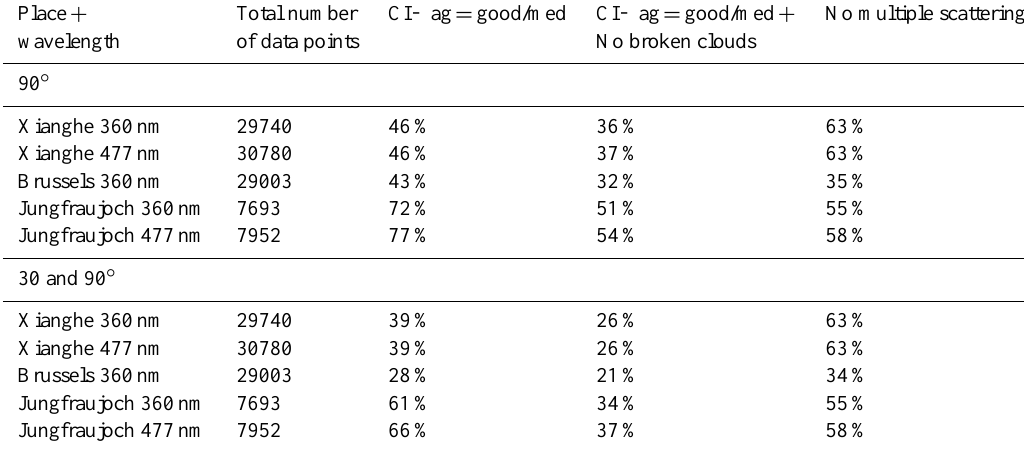
Xianghe 360nm 29740 39% 26% 63% Xianghe 477nm 30780 39% 26% 63% Brussels 360nm 29003